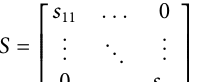
TABLE 2 | The calculation method of the evaluation value range corresponding to the suitability evaluation grade